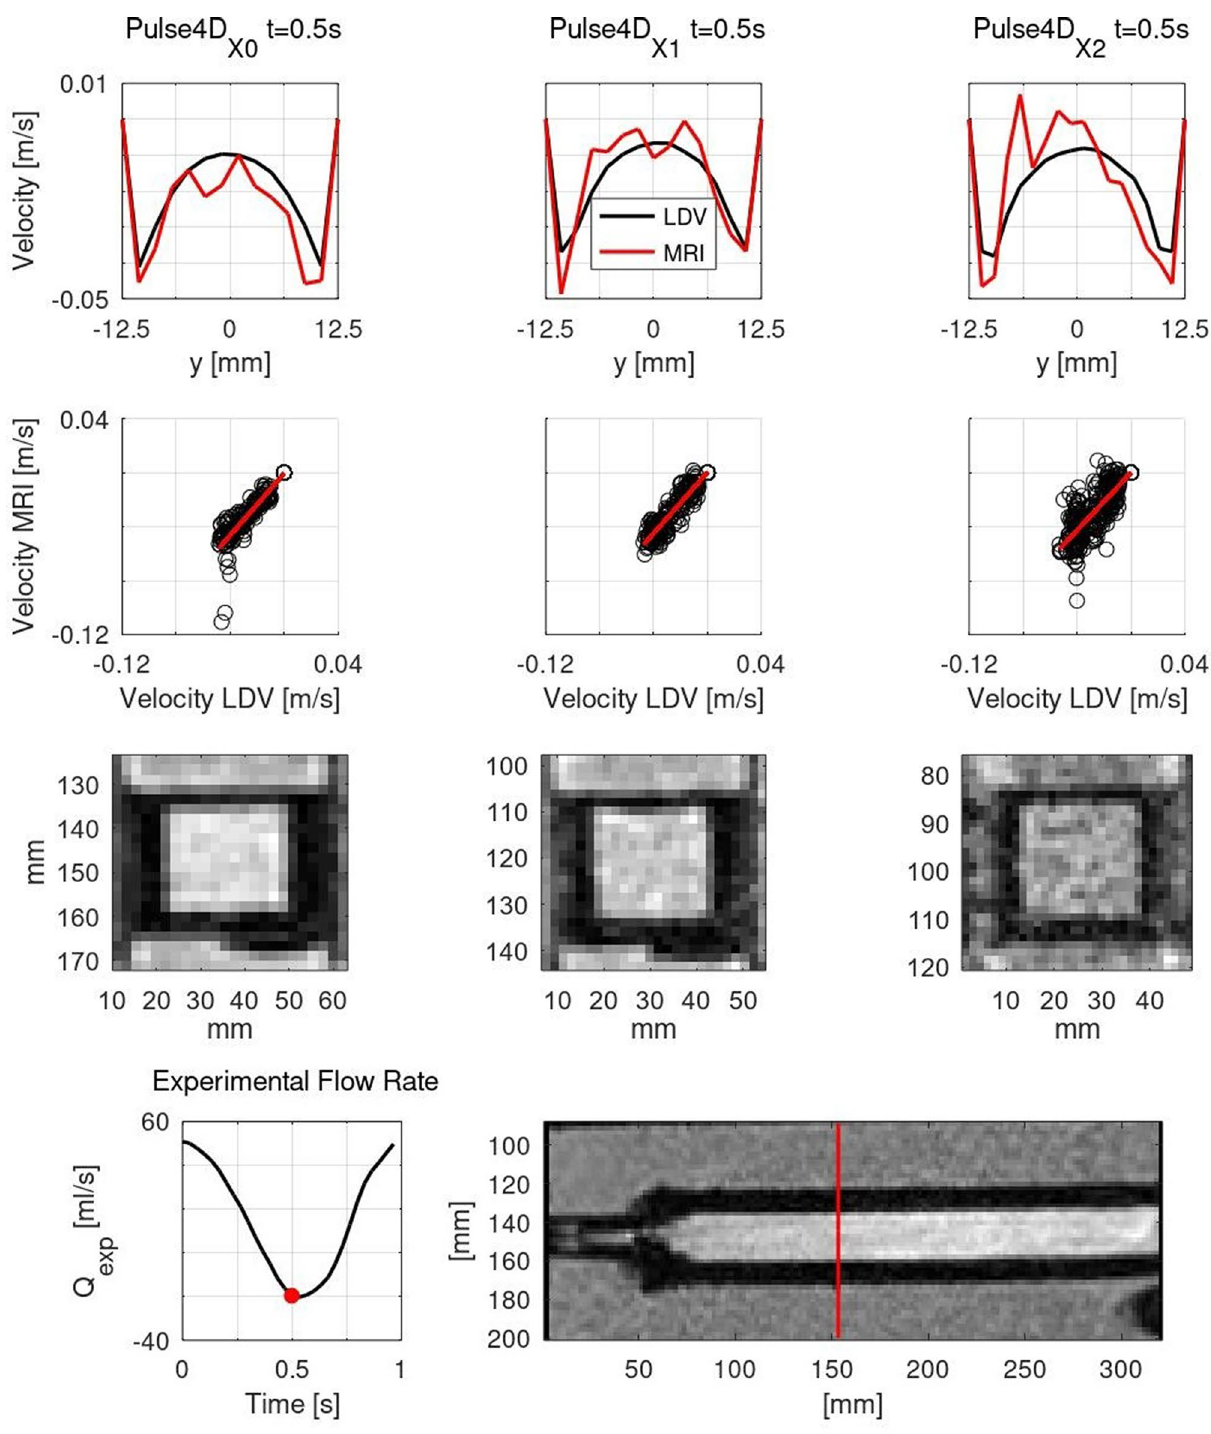
Figure 3. PC MRI Velocity Profiles, columns from left to right: Pulse4D X0 , Pulse4D X1 , Pulse4D X2 tests. First row: Velocity centerlines; Second row: Correlation plots with regression lines in red; Third row: Magnitude images; Fourth row: Flow rate and location of measurement cross-section in the test section, marked with the red